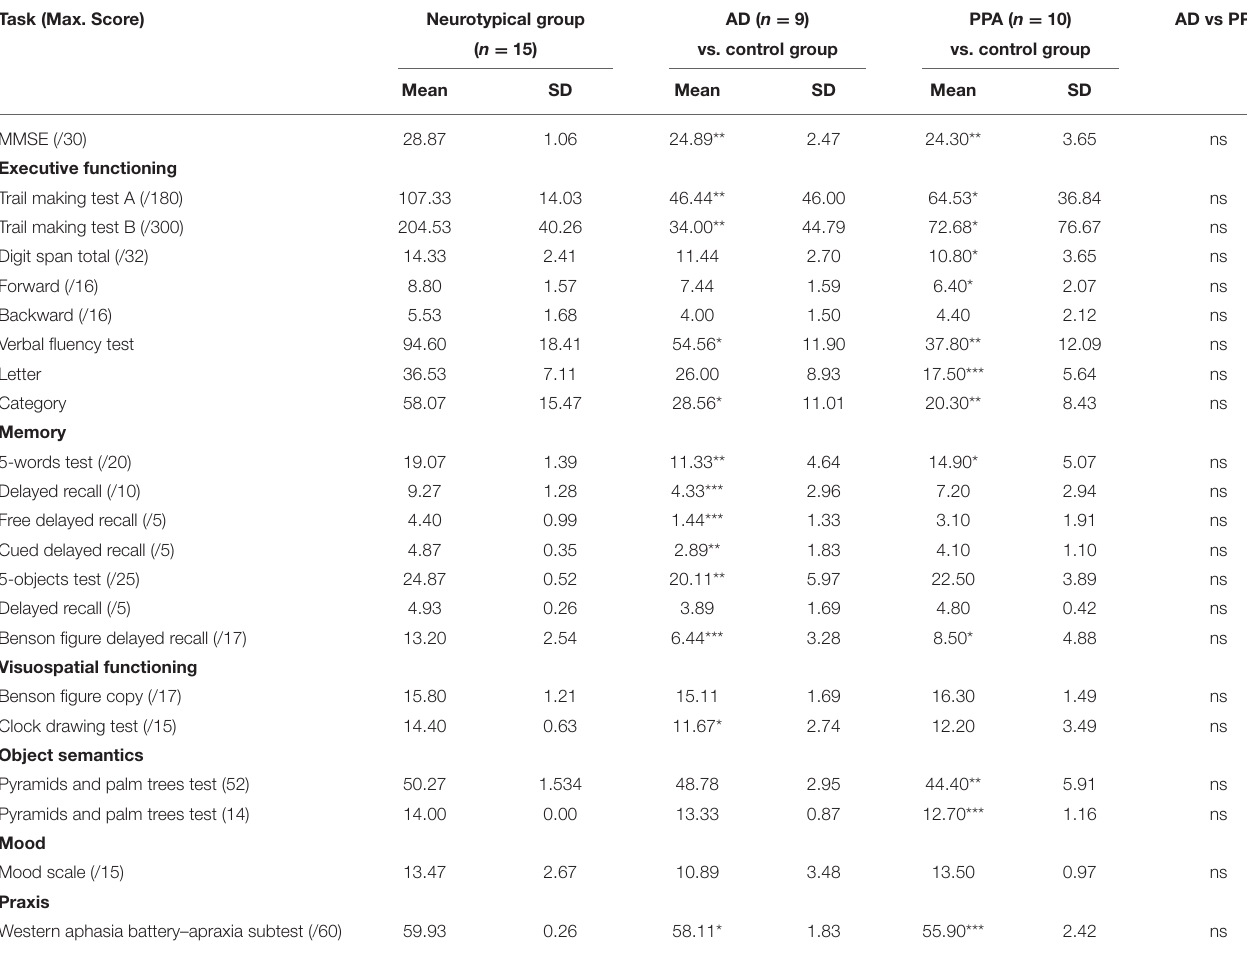
TABLE 2 | Group results for the cognitive-linguistic battery. Task (Max.